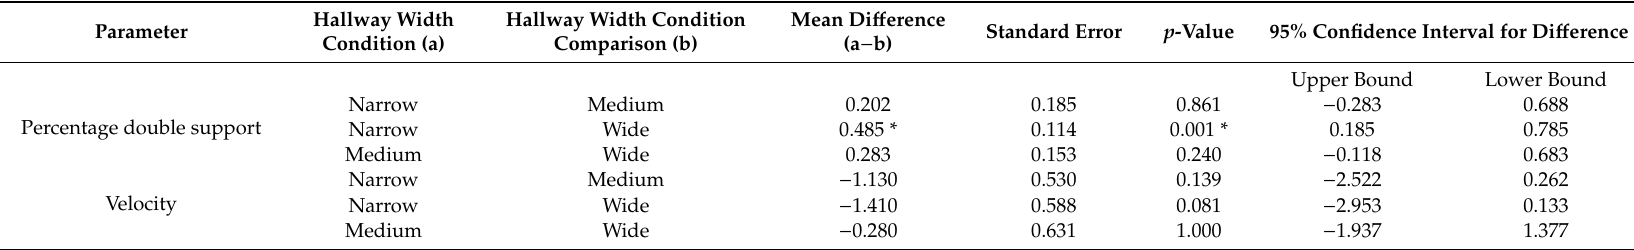
Table 3. Post-hoc pairwise comparison of significant main e ff